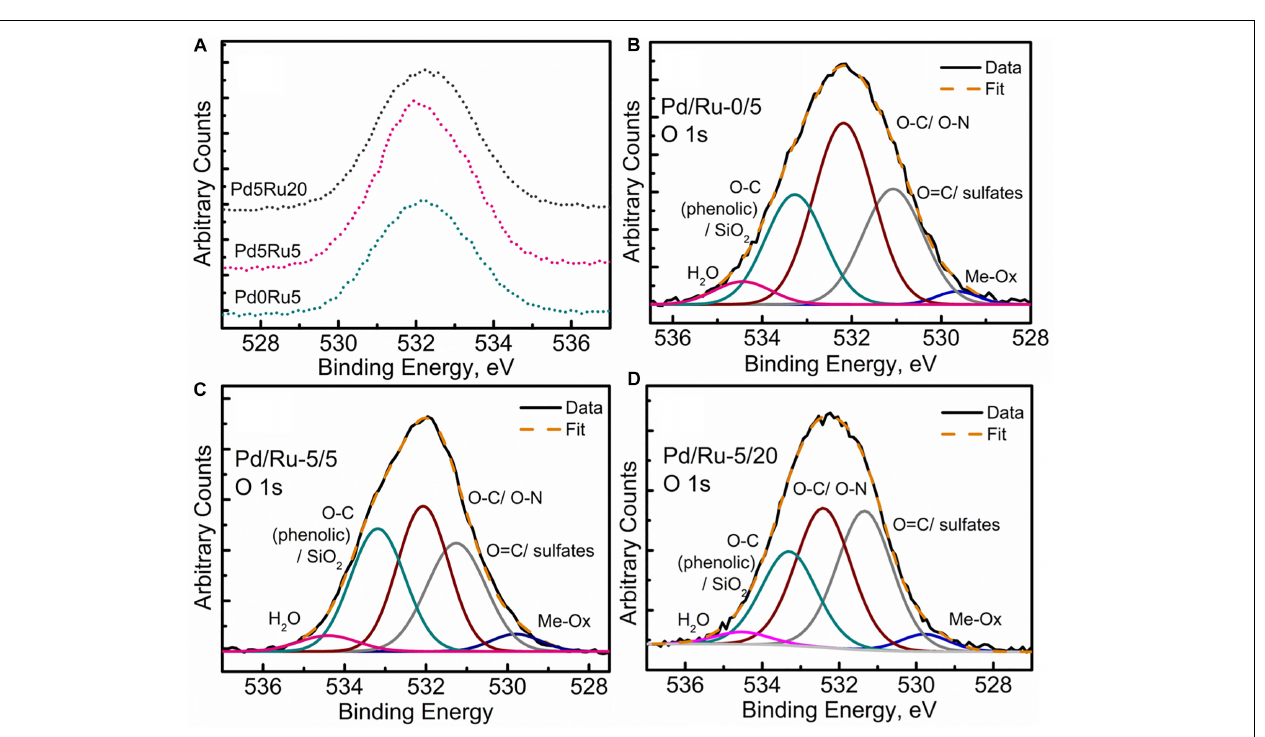
Frontiers in Microbiology |